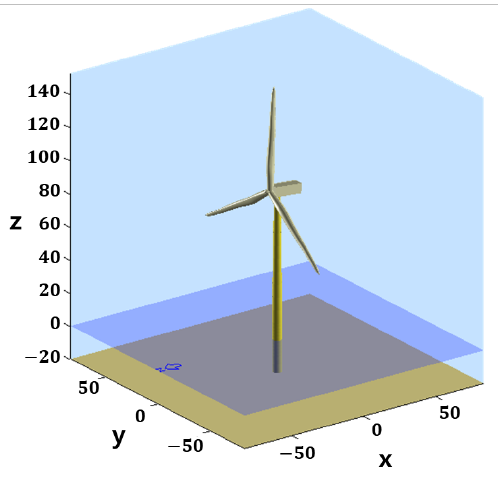
Figure 1. Images of the target NREL 5 MW large wind turbine.